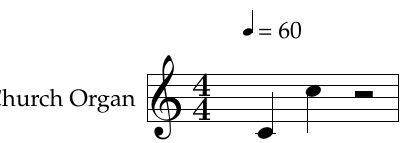
Figure 2. Resulting score from Iteration 1 (see Audio S2).